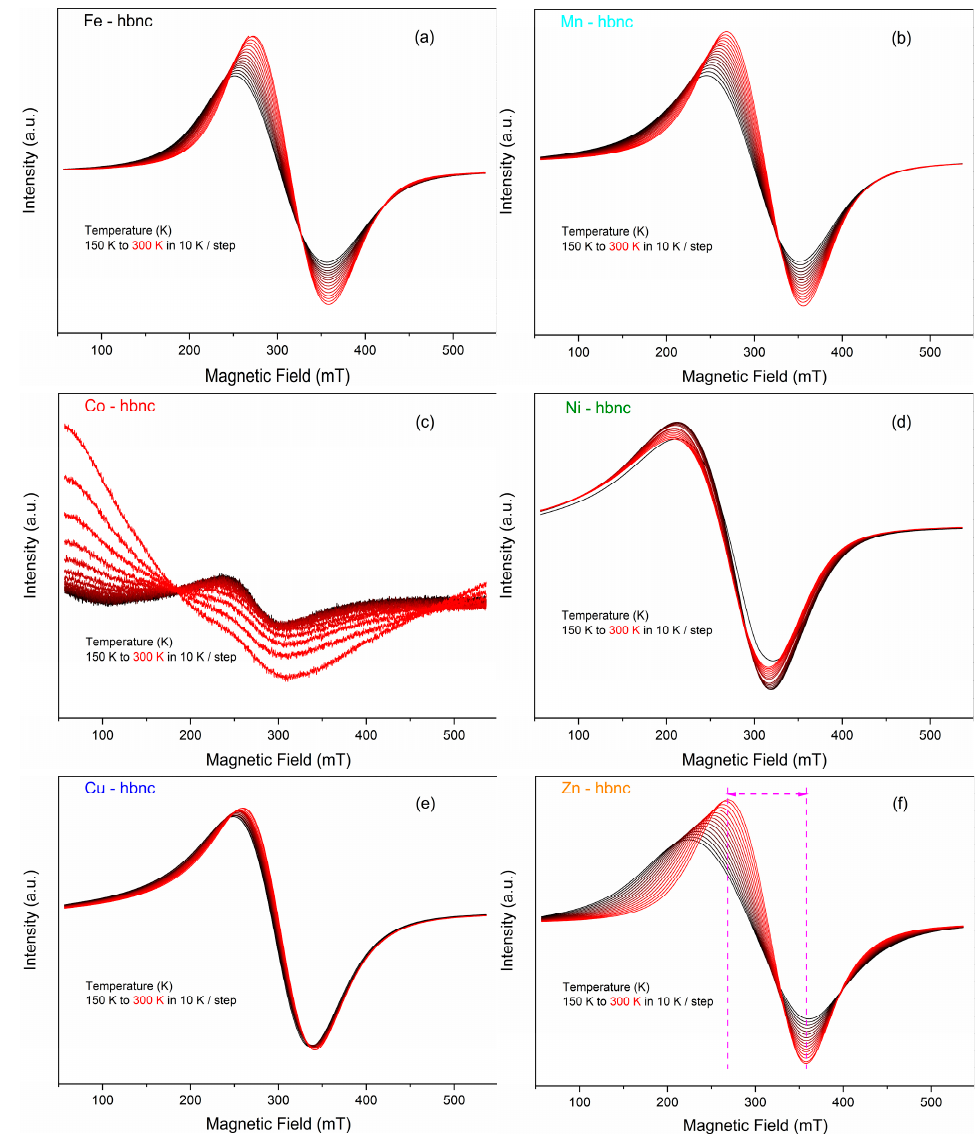
Figure 2. Temperature dependence of the Fe-hbnc ( a ), Mn-hbnc ( b ), Co-hbnc ( c ), Ni-hbnc ( d ), Cu-hbnc ( e ), and Zn-hbnc ( f ) EPR signals. Some species such as Mn-hbnc and Ni-hbnc do not significantly change the Fe 2 O 3 magnetic properties compared with Fe-hbnc . In contrast, these properties were drastically changed for Co- , Zn- , and Cu-hbnc samples. For Ni- and Cu-hbnc species, the EPR spec- tra are considerably broadened, which is also evidenced in Figure 3, where the peak-to- peak line width is plotted as a function of the temperature, indicating a strong exchange interaction between the dopant elements and iron. All samples show good doping of the second transition metal ion.